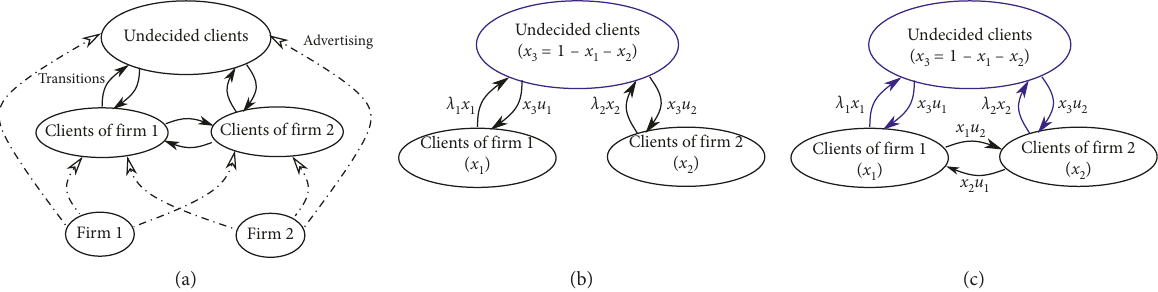
Figure 1: A graph representation of client and firm interactions in a duopoly with advertising. (a) The nodes represent clients and firms and the dotted arrows (edges) represent advertising which cause transitions (solid arrows) between them and (b) Vidale–Wolfe model and (c) extended Lanchester model, showing only transitions between client sets (refer to equations (7) and (11)). The extensions made to the original models are highlighted in